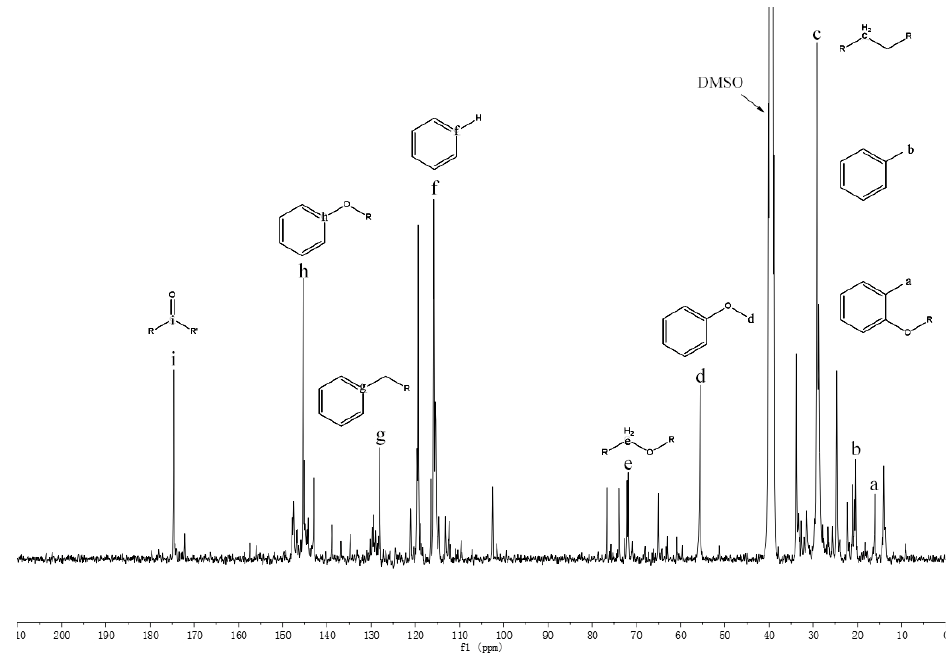
Figure 2. Quantitative 13 C NMR spectrum of pyrolysis oils produced from Douglas-Fir bark at 500 °C.